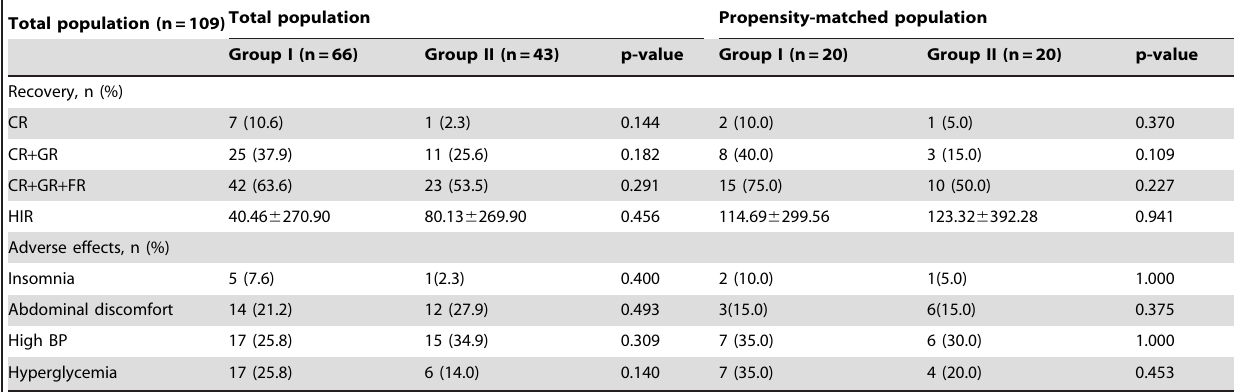
Table 3. Treatment outcomes according to different steroid